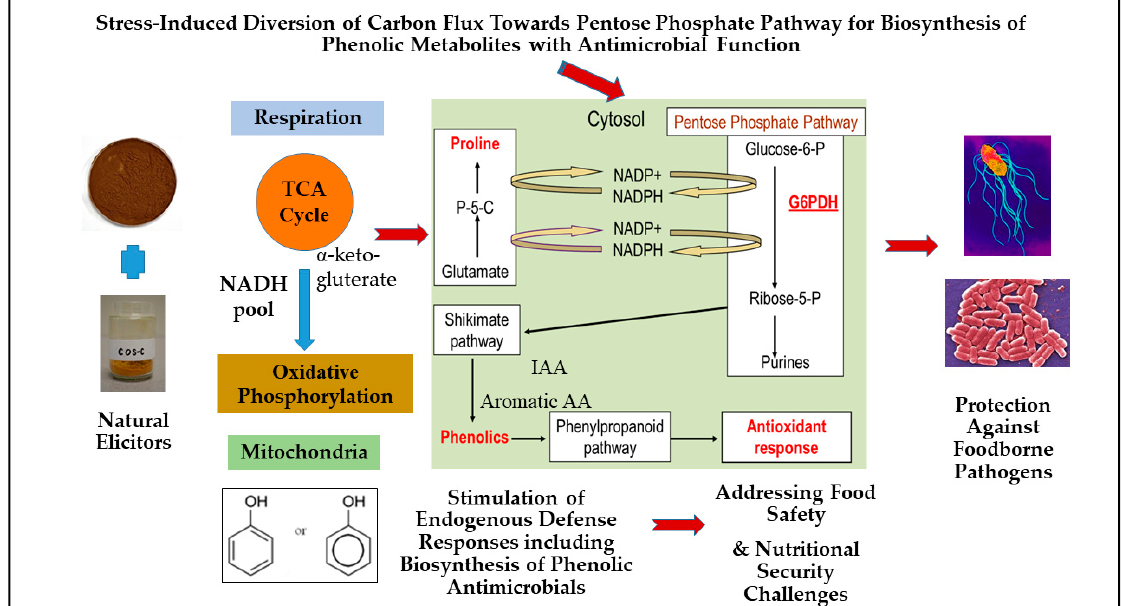
Figure 1. Proposed model of proline-associated pentose phosphate pathway (PAPPP) regulation for biosynthesis of stress-inducible phenolic metabolites in food plants with antimicrobial function. TCA: tricarboxylic acid cycle; NADH: nicotinamide adenine dinucleotide hydrogen; P-5-C: pyrroline-5-carboxylate; IAA: indole acetic acid; AA: amino acids; NADP+: nicotinamide adenine dinucleotide phosphate; NADPH: nicotinamide adenine dinucleotide phosphate hydrogen; Glucose-6-P: glucose 6 phosphate; Ribose-5-P: ribose-5-phosphate.